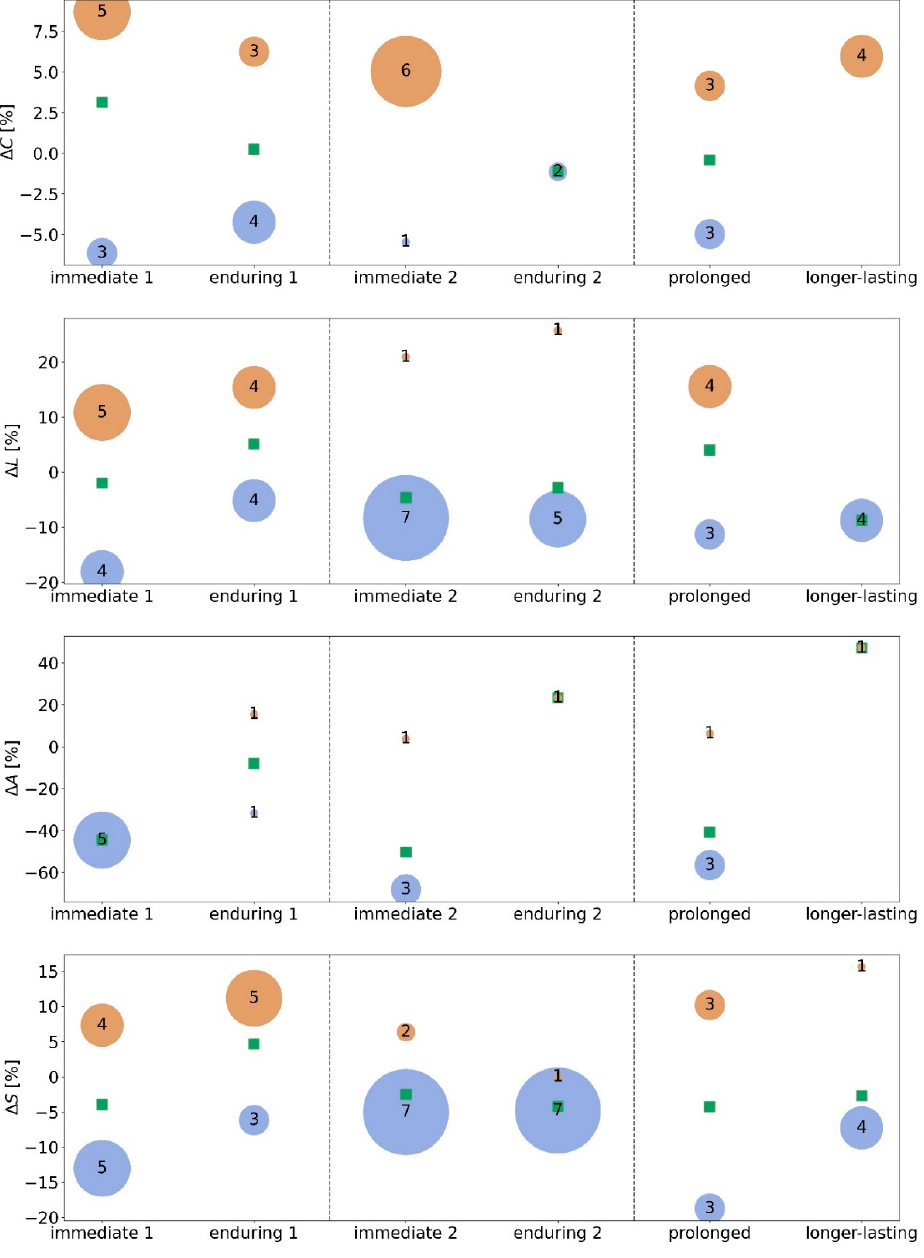
Figure 4. Bubble chart of taVNS-induced immediate, enduring, prolonged, and longer-lasting relative changes ∆ of global network characteristics of all responders (average clustering coefficient C , average shortest path length L , assortativity A , and synchronisability S ; ∆ = ( M l − M k )/ M k , where M k and M l denote placeholders for the temporal average of the respective characteristics from phase k and phase l; cf. Figure 1). Responders are assigned to subgroups according to their direction of change (positive/negative changes are shown in orange/blue). A disk is centred at a subgroup’s mean relative change, and the diameter of a disk encodes the number of subjects per subgroup. Mean relative changes from both groups are shown as green squares.